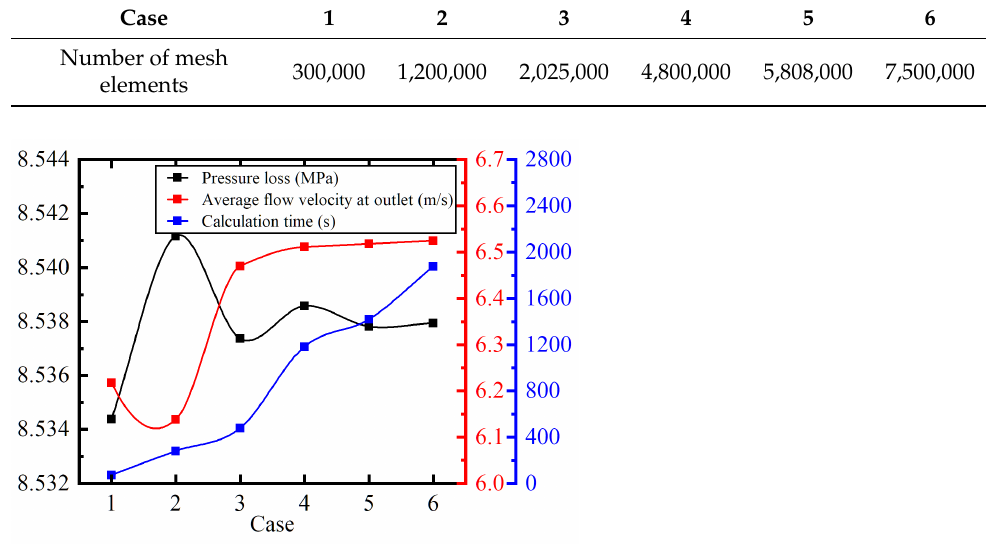
Figure 5. Pressure loss, average flow velocity, and calculation time versus total mesh